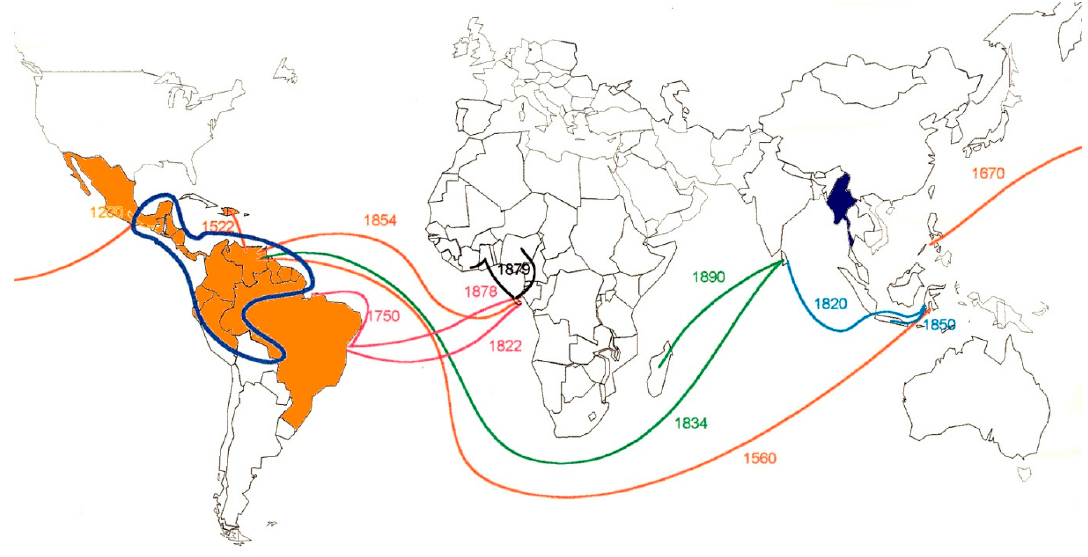
Figure 1. Expansion of cocoa cultivation from its area of origin, the American continent.